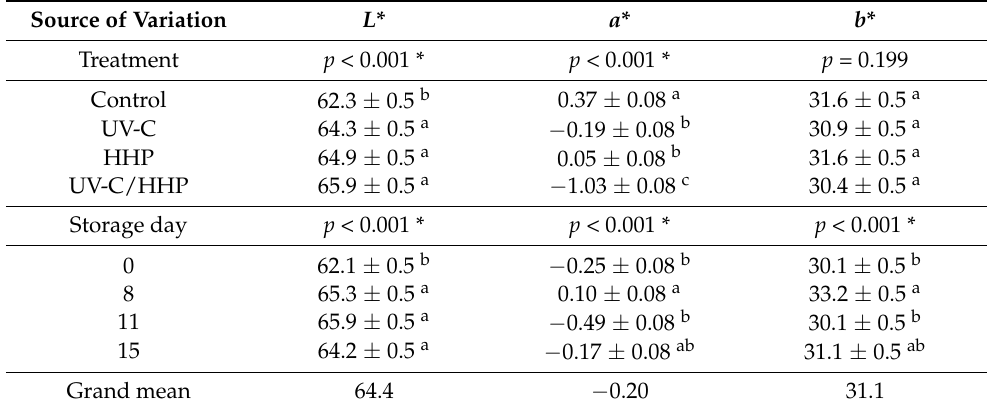
Table 2. The influence of UV-C, HHP, and UV-C/HHP treatment and storage time on the color parameters of raw, fresh-cut